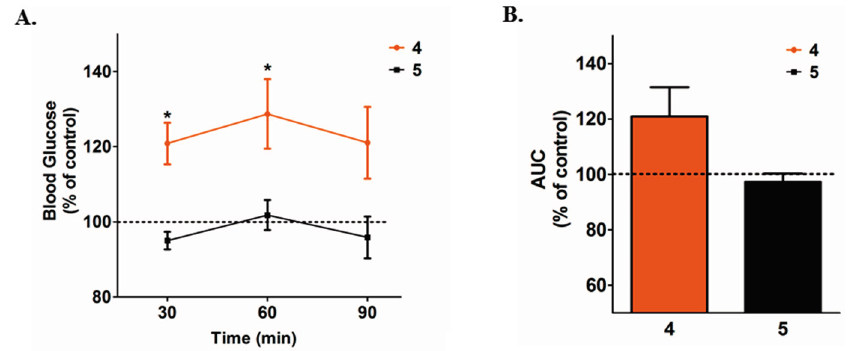
Figure 3. ( A ) Effect of a single intraperitoneal dose of 4 and 5 (3.0 mg/kg) on the blood glucose levels and ( B ) on area under the blood glucose response curve (AUC). Blood glucose levels and the AUC was calculated and expressed as percentage of saline treated group (mean ± SEM). * p < 0.05 vs. control.